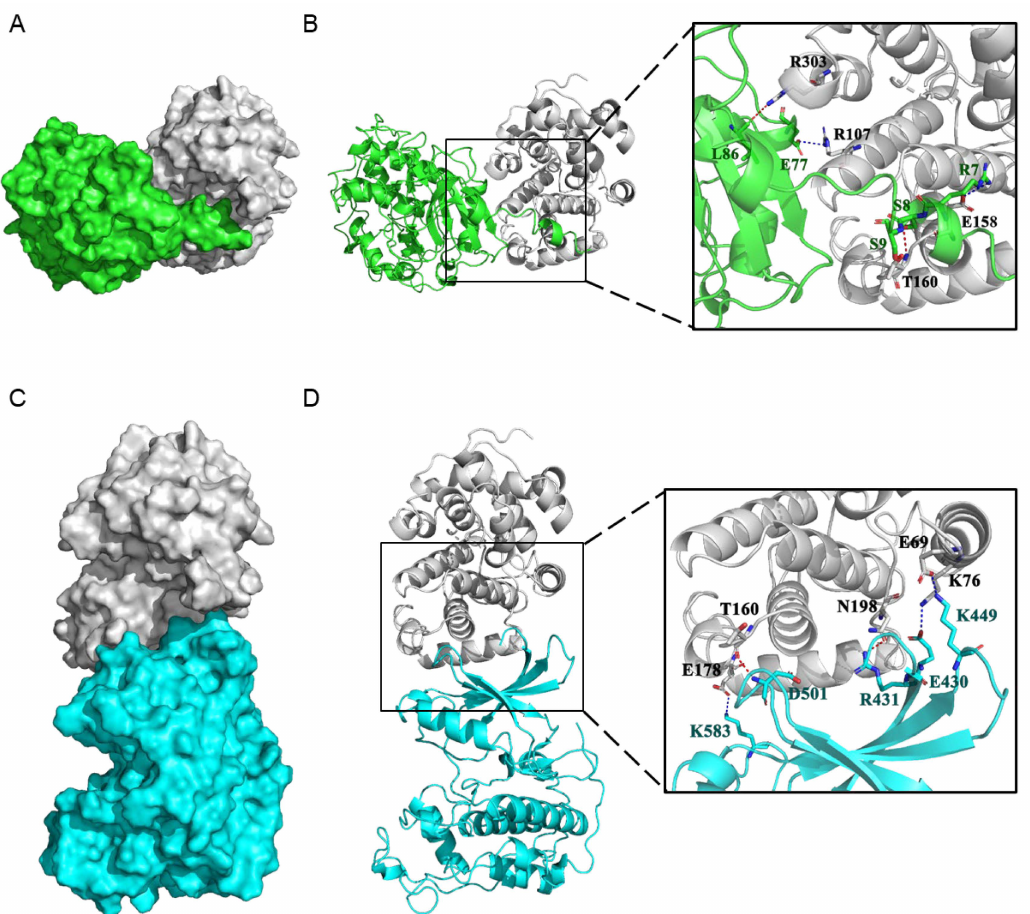
Figure 8. Protein–protein docking of PtoCYCD3;3 with PtoCDKE;2 and PtoCDKG;3. ( A ) Surface binding model between PtoCDKE;2 and PtoCYCD3;3. The surface of PtoCDKE;2 is colored in green. The surface of PtoCYCD3;3 is colored in gray90. ( B ) Detail binding model between PtoCDKE;2 and PtoCYCD3;3. The backbone of PtoCDKE;2 is depicted as green cartoon. The residues in PtoCDKE;2 are colored in green. The backbone of PtoCYCD3;3 is depicted as gray90 cartoon. The residues in PtoCYCD3;3 are colored in gray90. The red dashes represent hydrogen bond interaction, and the blue dash represents salt bridge. ( C ) Surface binding model between PtoCDKG;3 and PtoCYCD3;3. The surface of PtoCDKG;3 is colored in cyan. The surface of PtoCYCD3;3 is colored in gray90. ( D ) Detail binding model between PtoCDKG;3 and PtoCYCD3;3. The backbone of PtoCDKG;3 is depicted as cyan cartoon. The residues in PtoCDKG;3 are colored in cyan. The backbone of PtoCYCD3;3 is depicted as gray90 cartoon. The residues in PtoCYCD3;3 are colored in gray90. The red dashes represent hydrogen bond interaction, and the blue dash represents salt